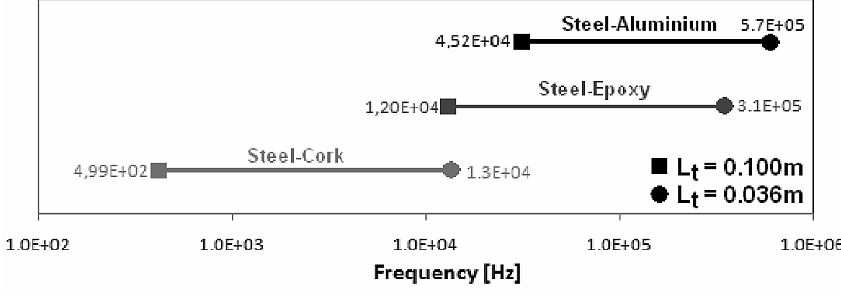
Fig. 6. First wide resonance gap (i.e. position of point A indicated at Fig. 2) for some pairs of materials.